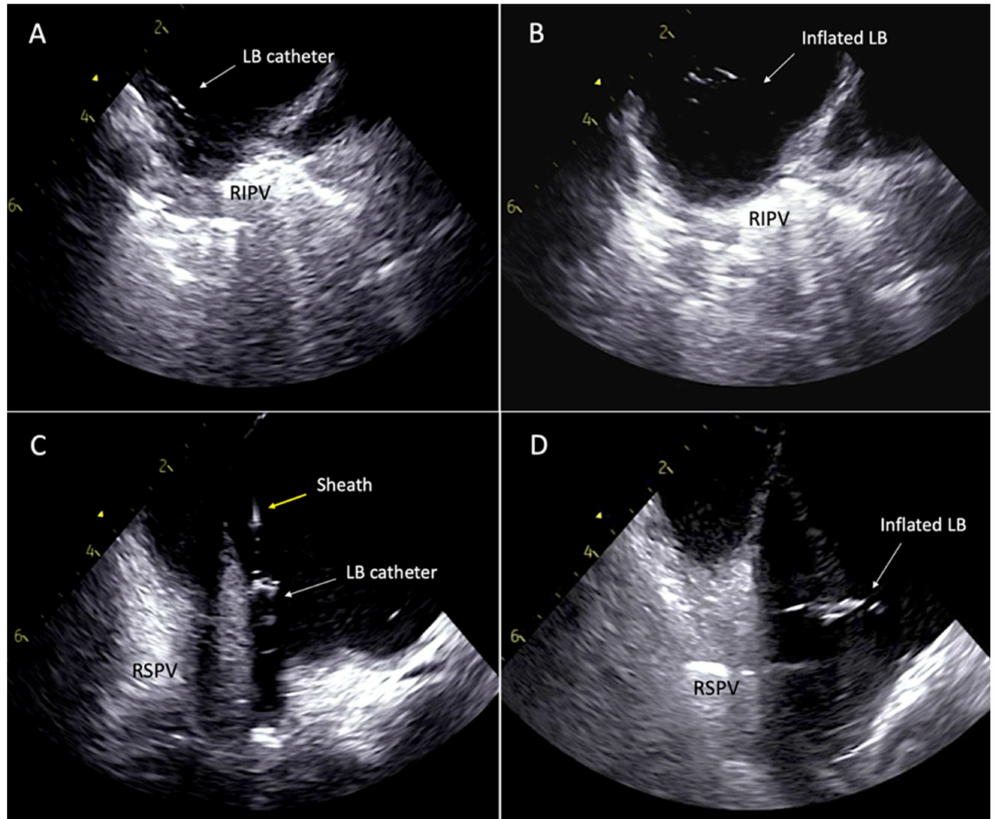
Figure 4. LB: laser balloon; RIPV: right inferior pulmonary vein; RSPV: right superior pulmonary vein; ICE: Intracardiac echocardiography. Low fluoroscopy ICE-guided approach for LB ablation. ( A , B ) LB catheter directed into RIPV using ICE guidance and inflated prior to ablation. ( C , D ) RSPV cannulated under ICE and inflated into antral